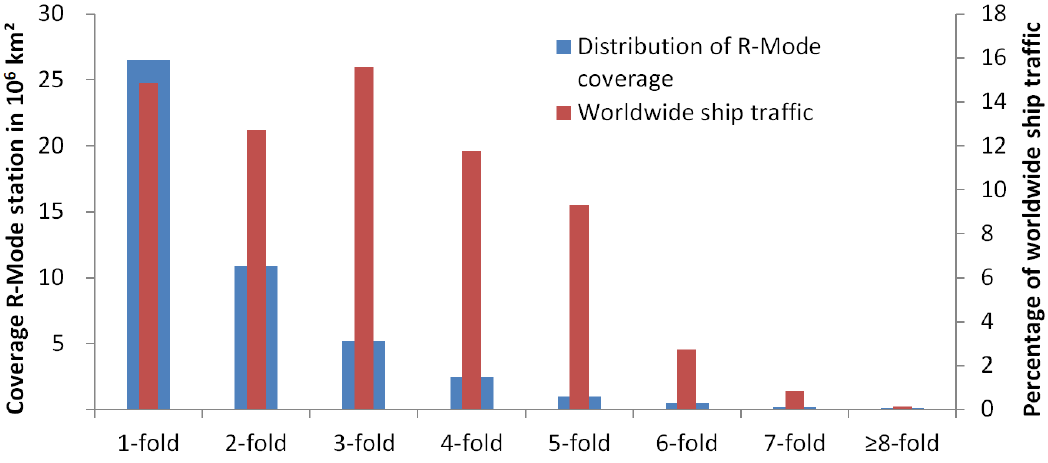
Figure 9. Comparison of R-Mode coverage and traffic density.